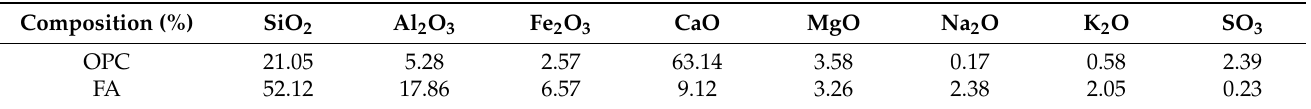
Table 2. Composition of OPC and FA.